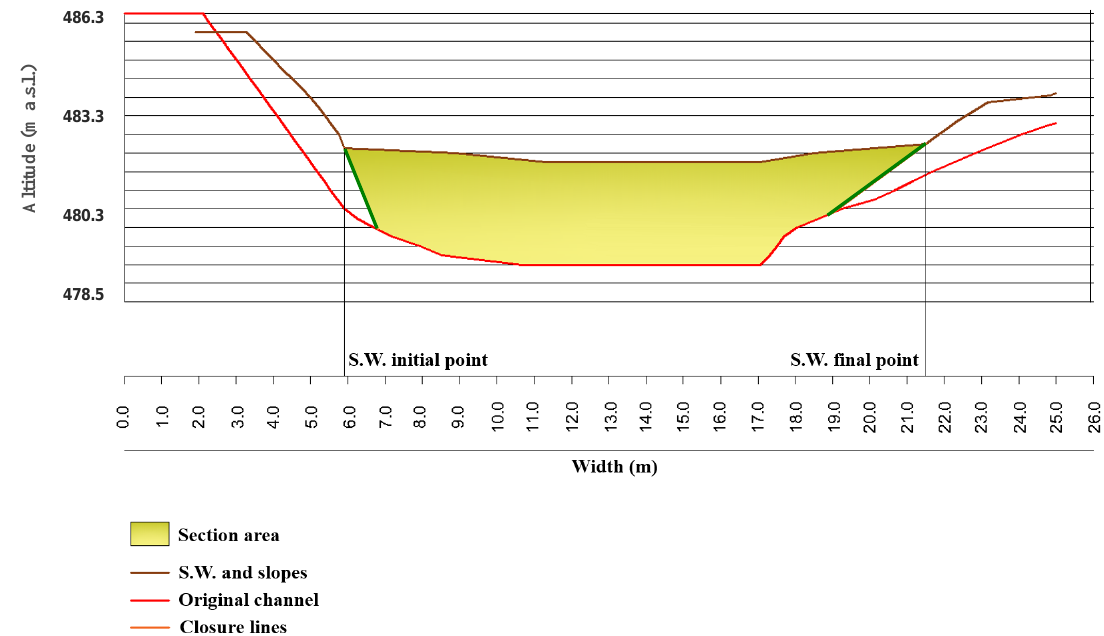
Figure 3. Example of a channel cross section in proximity of a check dam (the brown line is the sediment wedge profile, the red line the channel profile, and the green line is the hypothesized bank profile close to the sediment wedge; the yellow-shadowed line is the area of the channel cross section).